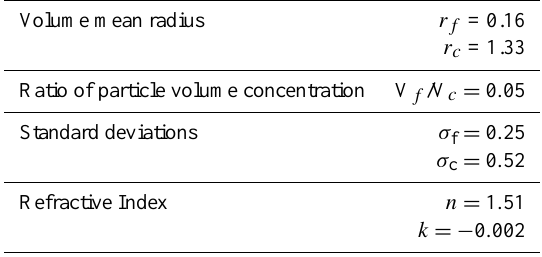
Table A1. Example of the assumed aerosol parameters used in the sensitivity tests (f: fine mode, c: coarse